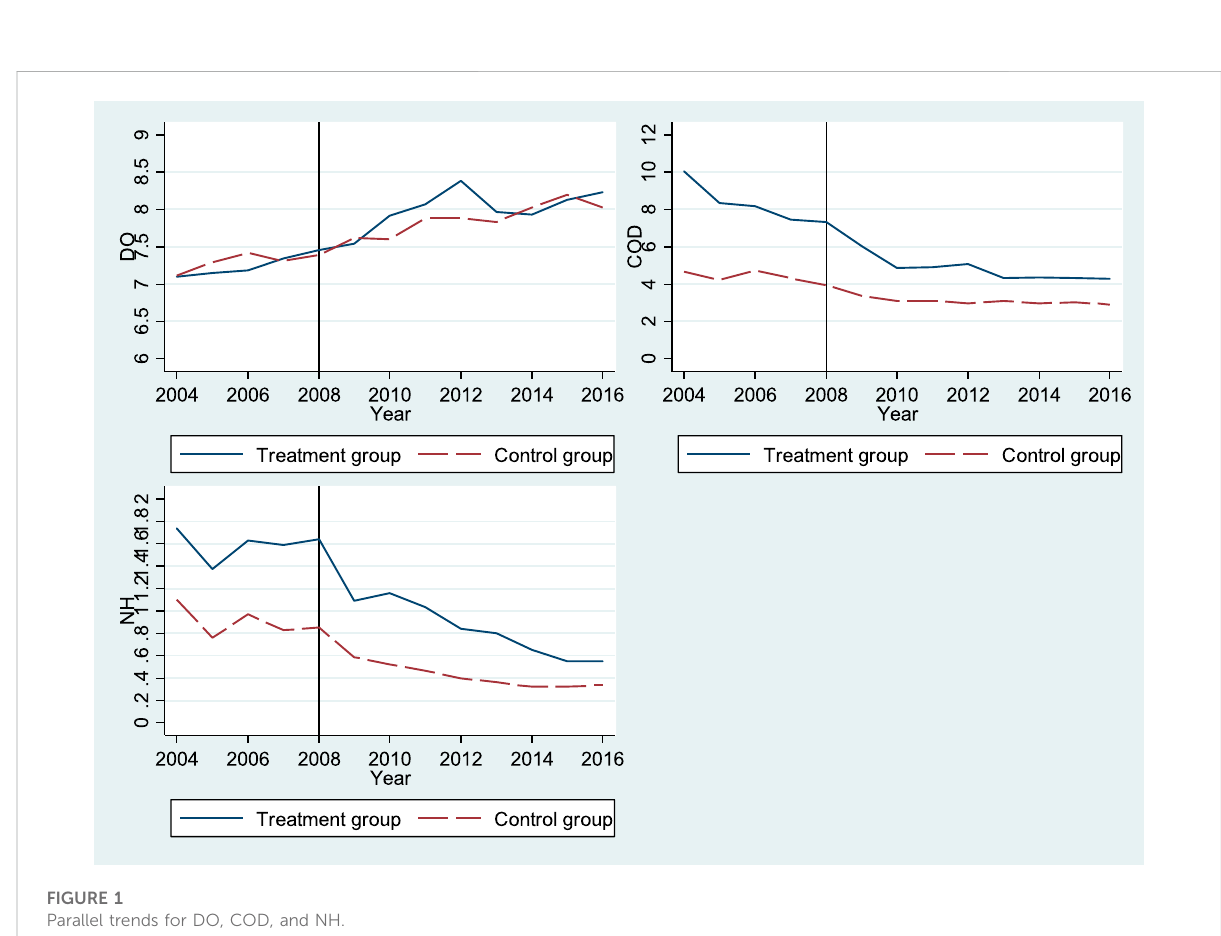
FIGURE 1 Parallel trends for DO, COD, and